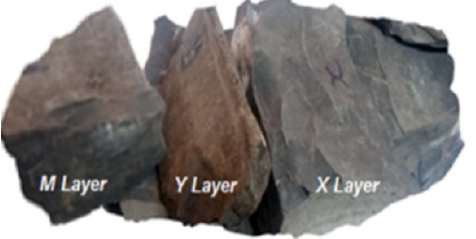
Figure 3. Samples of oil shale M, Y and X layers of the Timahdit deposit.